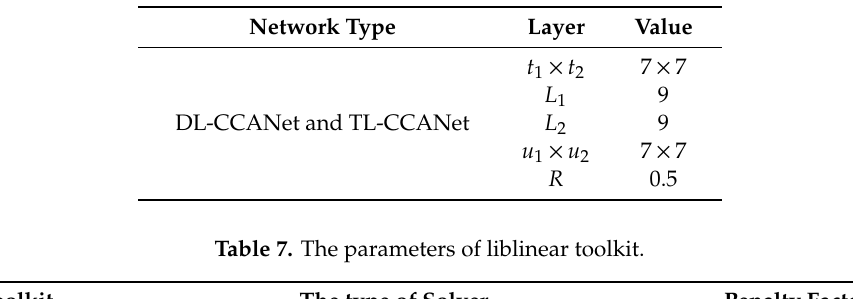
Table 6. The parameters set for DL-CCANet and TL-CCANet.